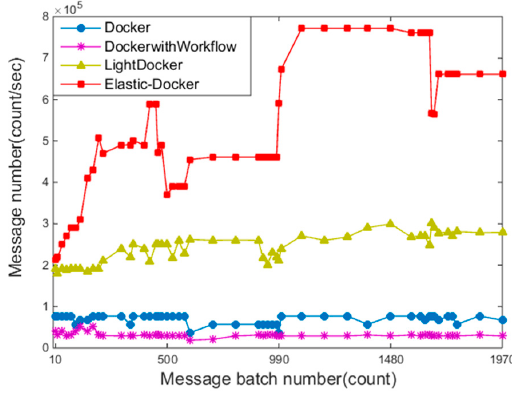
Figure 7. Comparison of the message throughput.